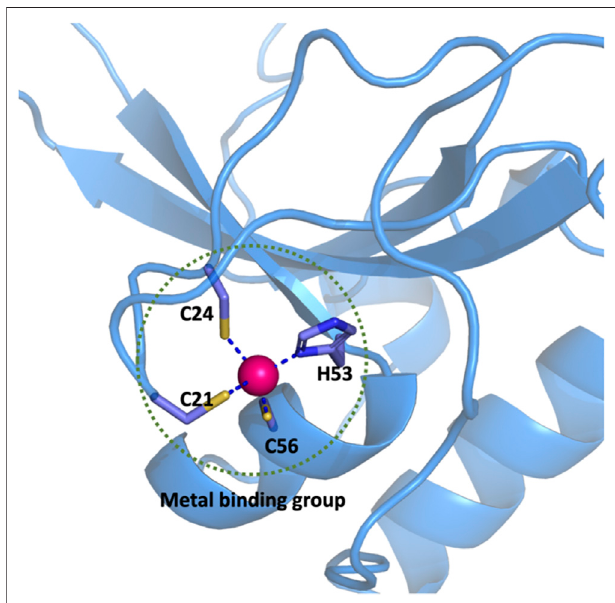
FIGURE 1 | De fi nition of the metal binding group in a CCCH-type zinc fi nger protein.